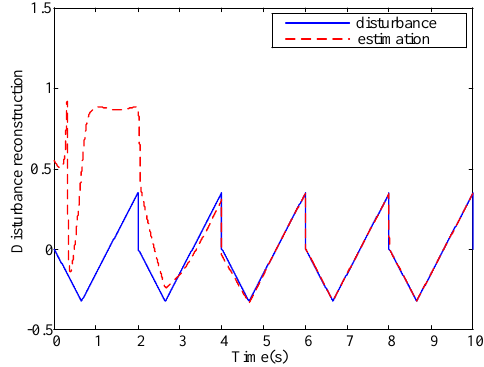
Figure 8. Discontinuous input recovery by SMO.